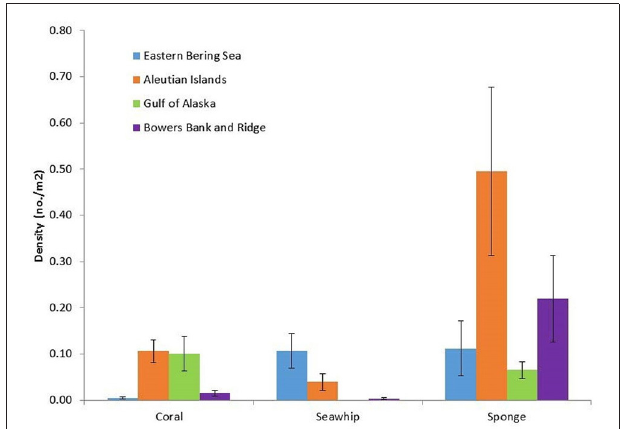
FIGURE 2 | Comparison of density of corals, seawhips, and sponges in the Eastern Bering Sea, Aleutian Islands, Gulf of Alaska, and Bowers Bank and Ridge,